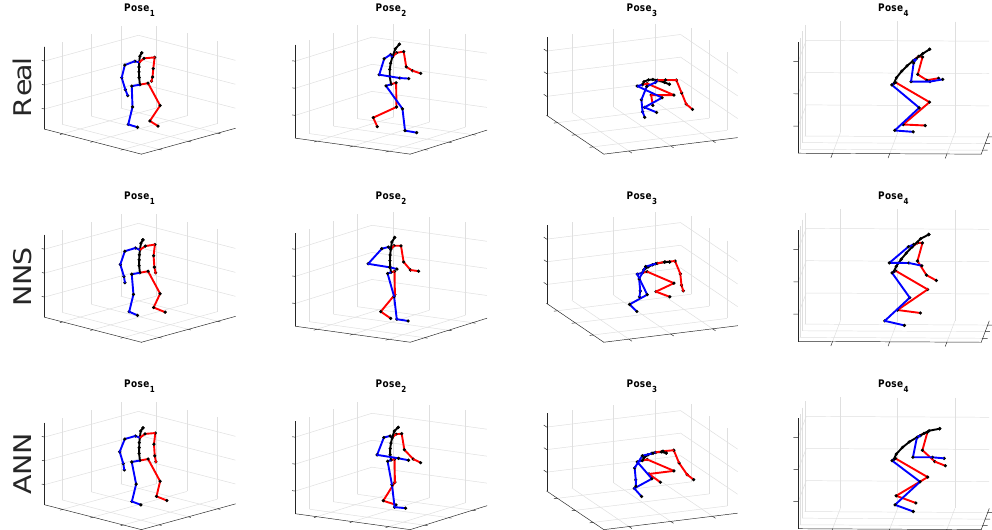
Figure 2. Measured and estimated poses of one subject are shown for different activities. Body segments on the left-side of the subject are colored red, while the right-side is colored blue. Joints are marked by black dots. The top row shows the measured poses of the testing dataset, the middle row shows poses estimated by NNS, and the bottom row shows those poses estimated by ANN (configuration D). Pose 1 shows a pose in mid swing, pose 2 is directly after toe off while carrying two cups, in pose 3 , a tray of cups is picked up and the subject is squatting in pose 4